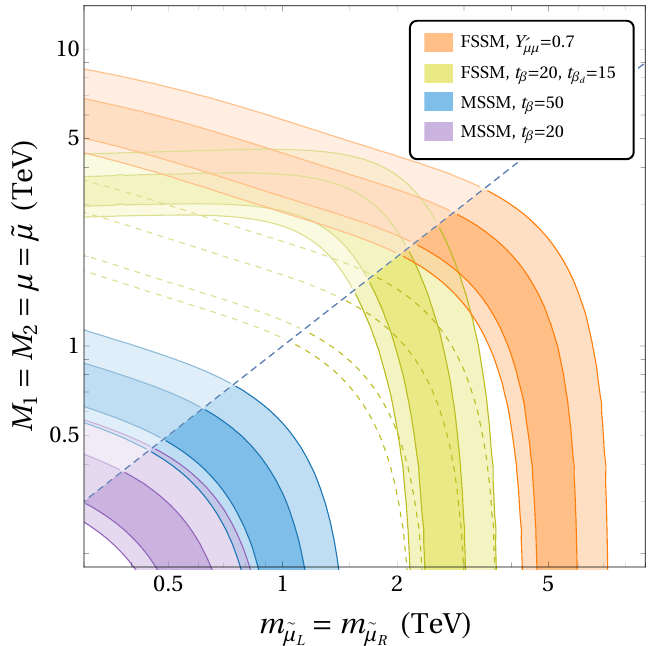
Figure 2 . Regions of SUSY parameter space that are preferred by the anomalous magnetic moment of the muon at the 1 σ and 2 σ level in several benchmark models. Above the dashed diagonal line, the smuons are lighter than any of the gauginos and Higgsinos. In blue and purple, we present two MSSM scenarios; in yellow and orange two FSSM scenarios. The dashed yellow lines show the corresponding FSSM scenario neglecting the SUSY threshold corrections to the muon